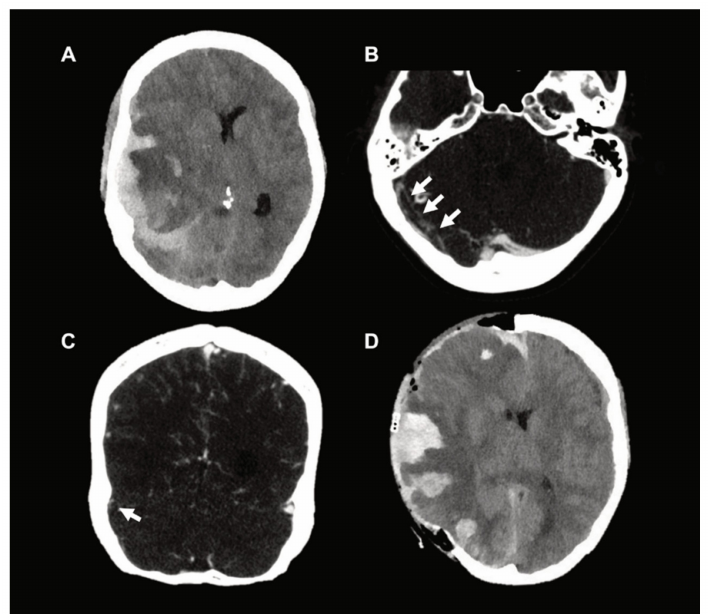
Figure 1. ( A ) Preoperative CT scan which demonstrates parenchymal stasis hemorrhage and a spontaneous acute subdural hematoma with associated midline shift and impending herniation. ( B , C ) Axial and coronal images, respectively, which demonstrate marked sinus vein thrombosis